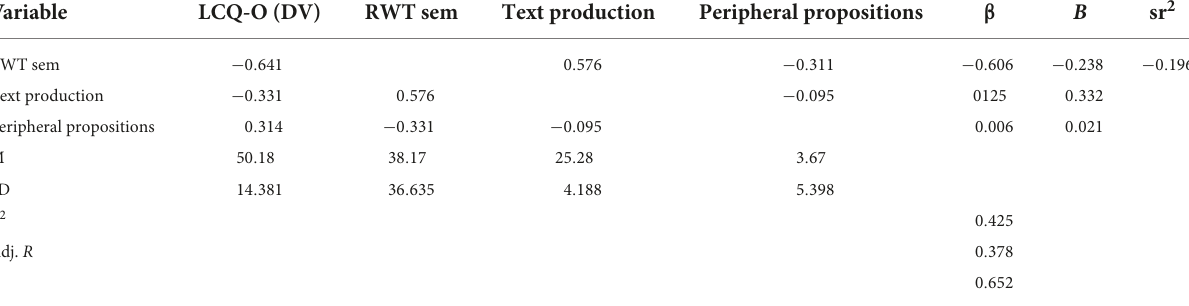
TABLE 8 Standard multiple regression of discourse production variables and RWT-sem on LCQ-O total scores for IwTBI and controls ( n = 46). Variable LCQ-O